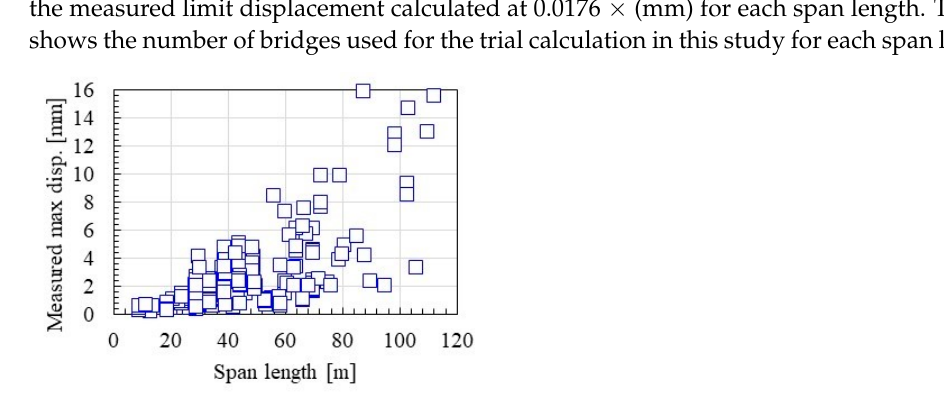
(246 high-speed railway bridges).